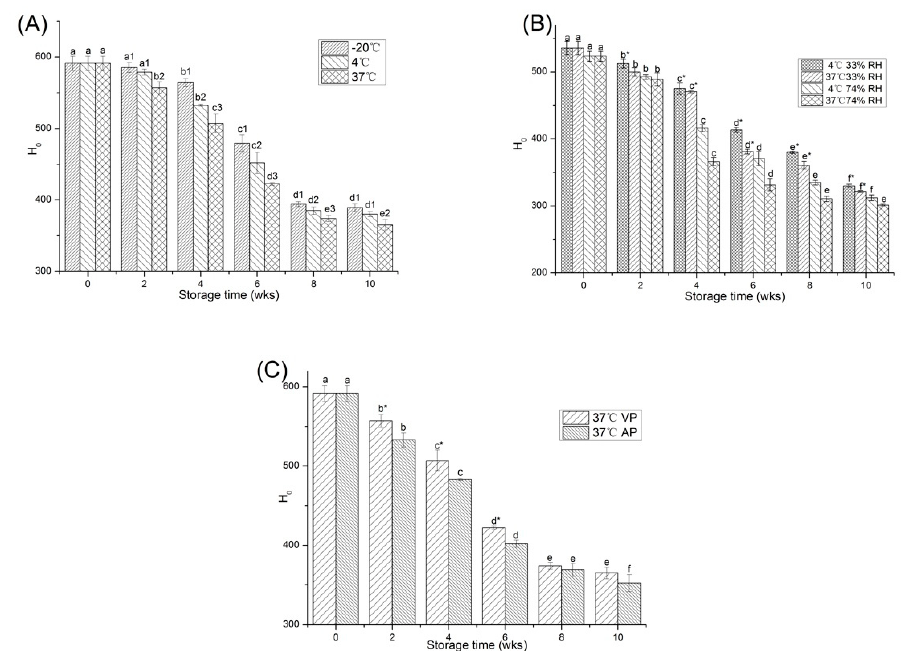
Figure 4. Changes in the H 0 of PPI stored at different temperature ( A ), relative humidity ( B ) and packaging methods ( C ). a–f means the significant difference between the same treatments with different weeks ( p < 0.05). 1–3 means the significant difference between the same weeks with different temperature ( A ) ( p < 0.05). * means the significant difference between the same weeks and temperature with different relative humidity ( B ) or between the same weeks with different packaging methods ( C ) ( p < 0.05 ) .